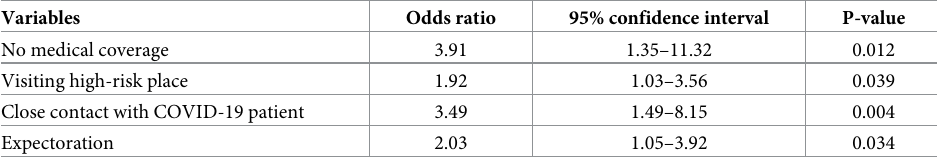
Table 6. Multivariate regression analysis of risk factors for COVID-19.